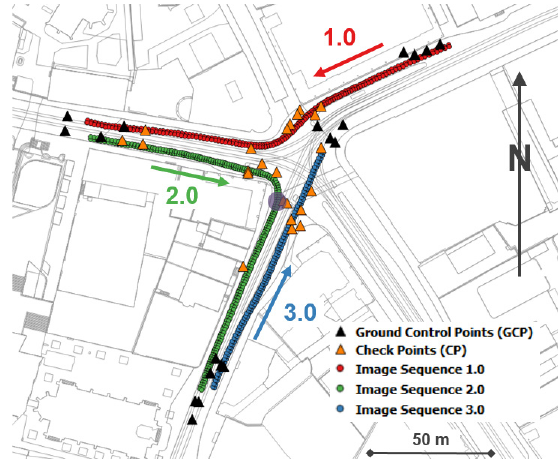
Figure 3. Base map of the study area with overlaid projection centers of selected stereo image sequences, ground control points, check points and vehicle location at the time of capturing the images of Figure 4 (purple filled circle) (Source: Geodaten Kanton